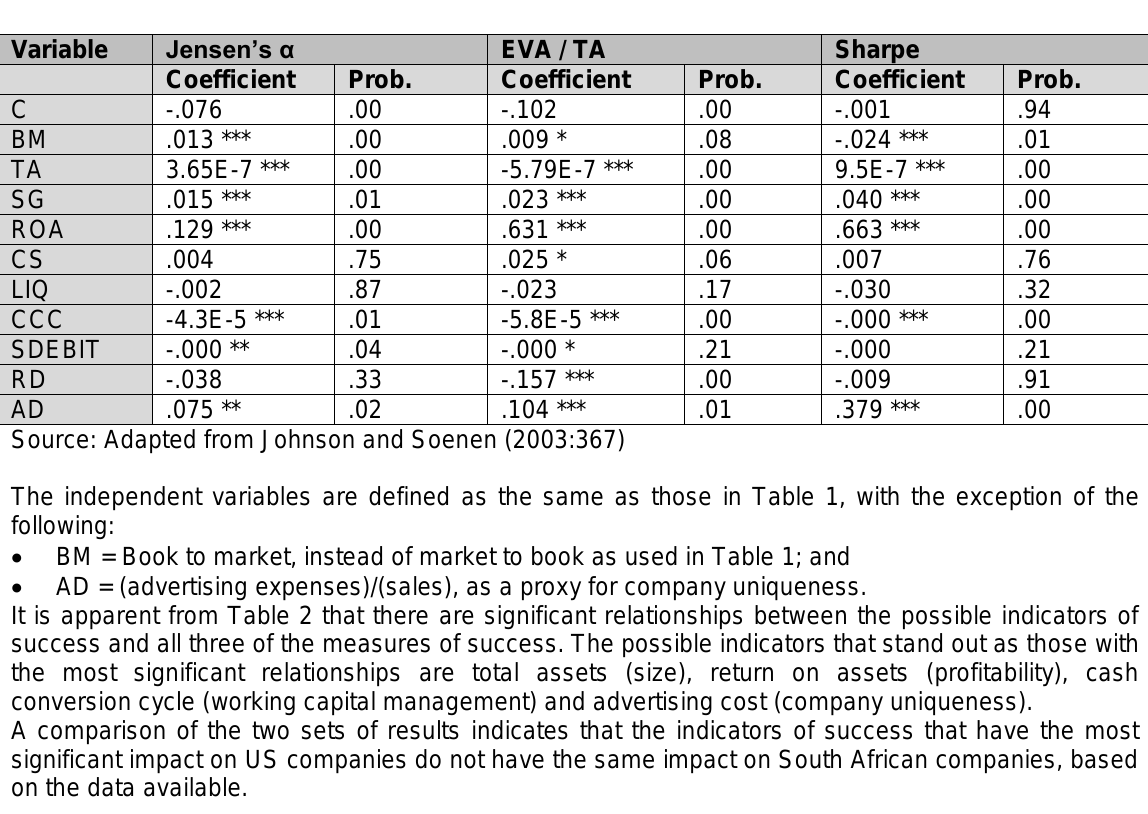
Regression results of US